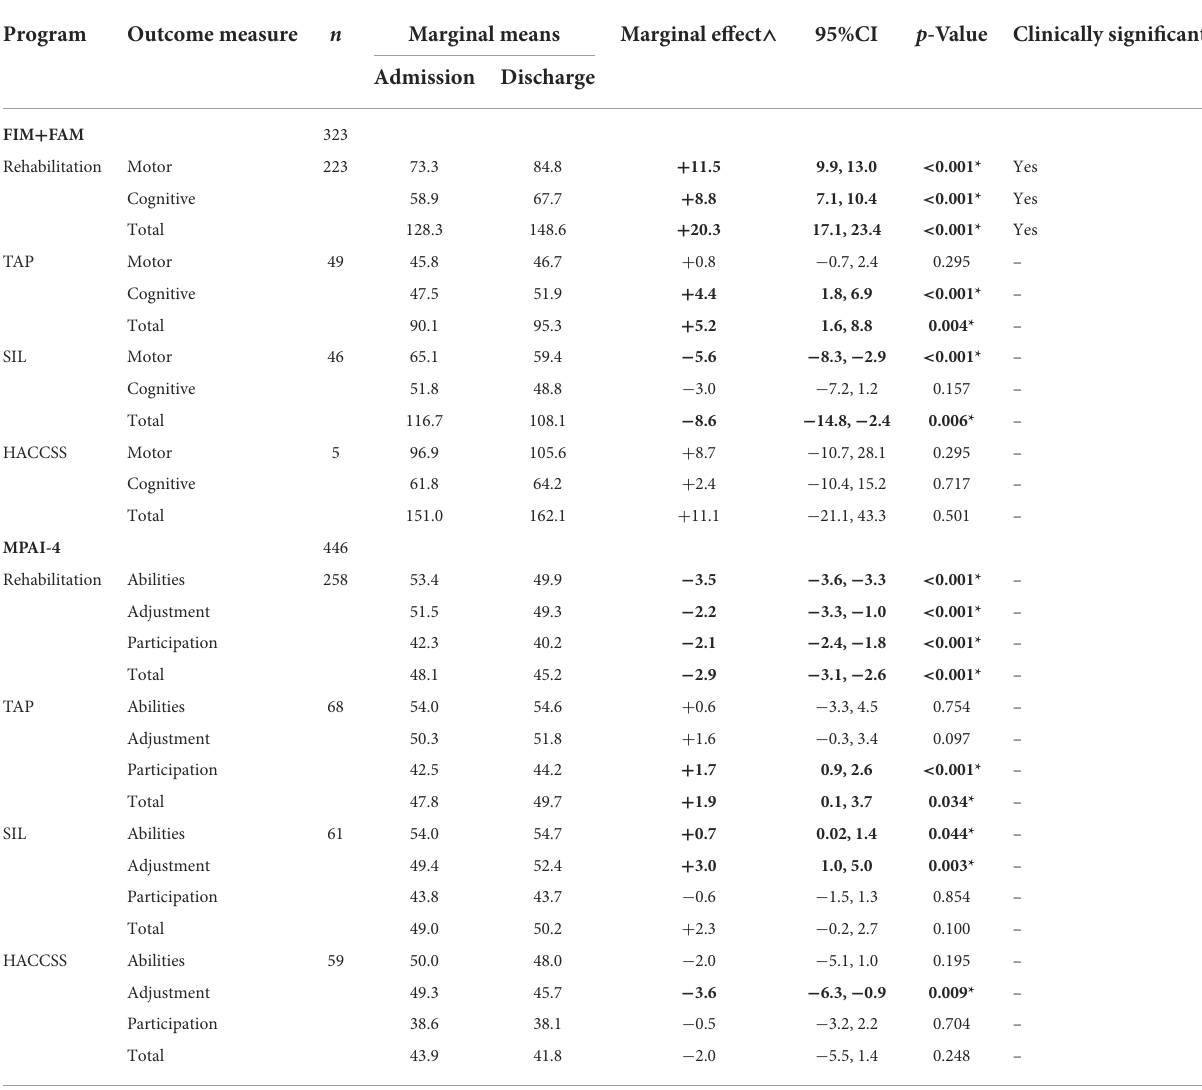
TABLE 2 Mean change in FIM + FAM and MPAI-4 score at discharge by program, 2011–2020.